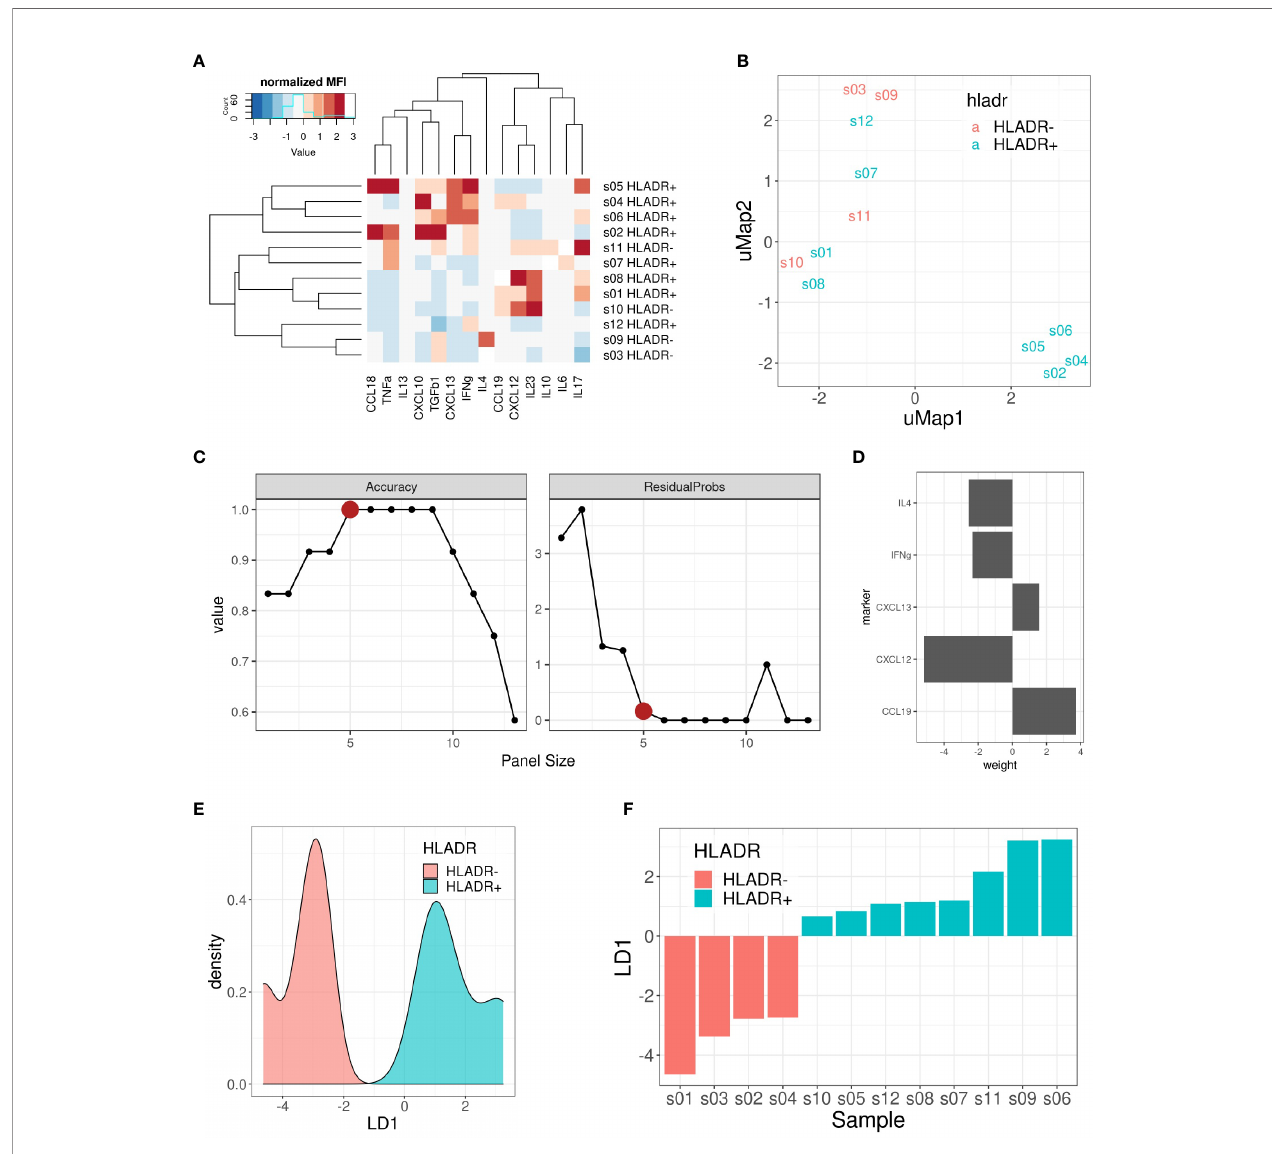
FIGURE 7 | Multiplex ELISA assay. (A) Heat map representing the normalized (z-score) mean fl uorescence intensity (MFI) of the 14 measured cytokines (columns) in the 12 samples included (rows). Both rows and columns are sorted based on hierarchical clustering. (B) uMap representing the partial separation of HLA-DR+ and HLA-DR- samples by unsupervised dimensionality reduction. (C) Pareto front representing model accuracy (left) and residual probability (right) of the best LDA model for each panel size (x-axis). Elbow criterion identi fi ed a panel size of 5 markers as the optimal one. (D) Weights of the 5 included cytokines for the optimal LDA model: CCL19, CXCL12, CXCL13, IFN g and IL4. (E) Density plot on LD1 for the included samples. (F) Bar plot showing the separation of HLA-DR+ and HLA-DR- samples following the predictions made with the 5 cytokine